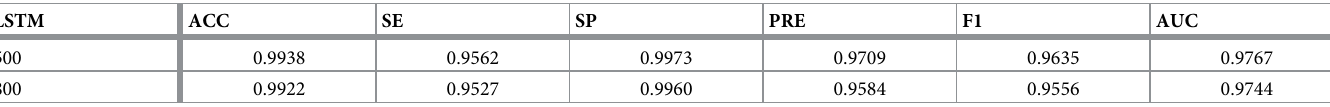
Table 7. LSTM results (1 st